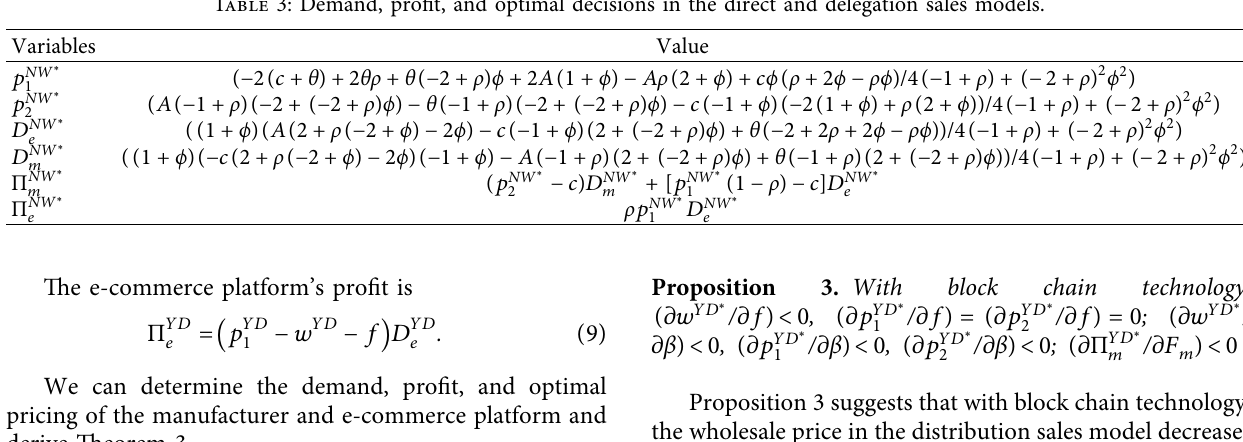
Table 2: Demand, profit, and optimal pricing decisions in the direct and distribution dual-channel retail models. Variables